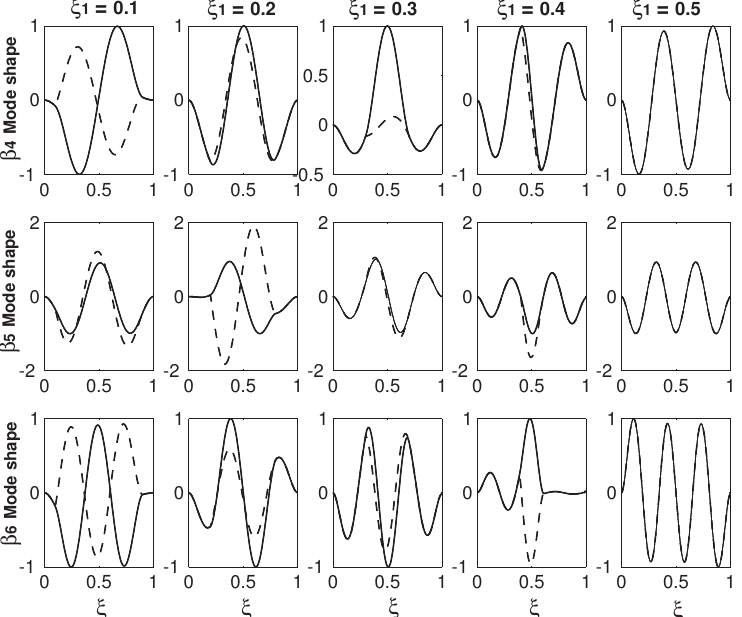
Figure 7. The mode shape variations of the last three eigenfrequencies ( β 4 , β 5 and β 6 ) as the functions of the overhang length ξ 1 . The first, second and third rows correspond to the mode shapes of β 4 , β 5 and β 6 ,